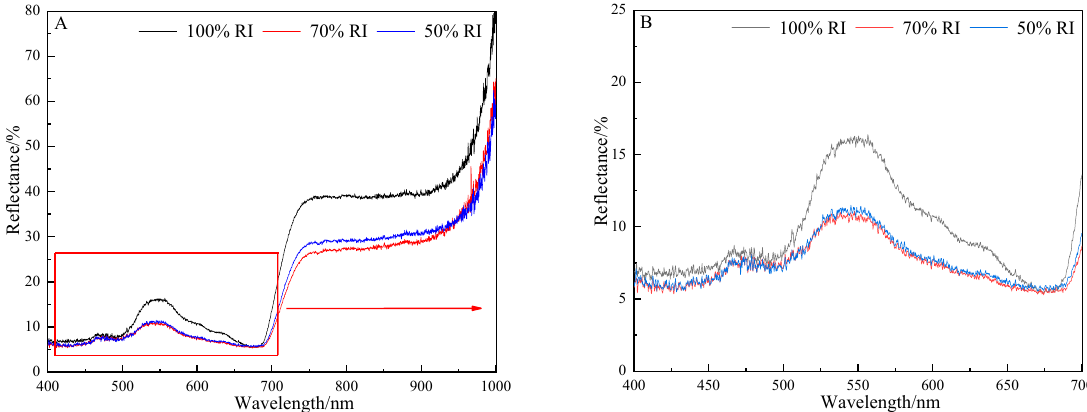
Figure 2. The mean spectral reflectance curves for P. massoniana seedling needles at 400–1000 nm ( A ) and within the visible light spectrum at 400–700 nm ( B ) under different light treatments ( n = 6). Abbreviations: RI, relative irradiance.